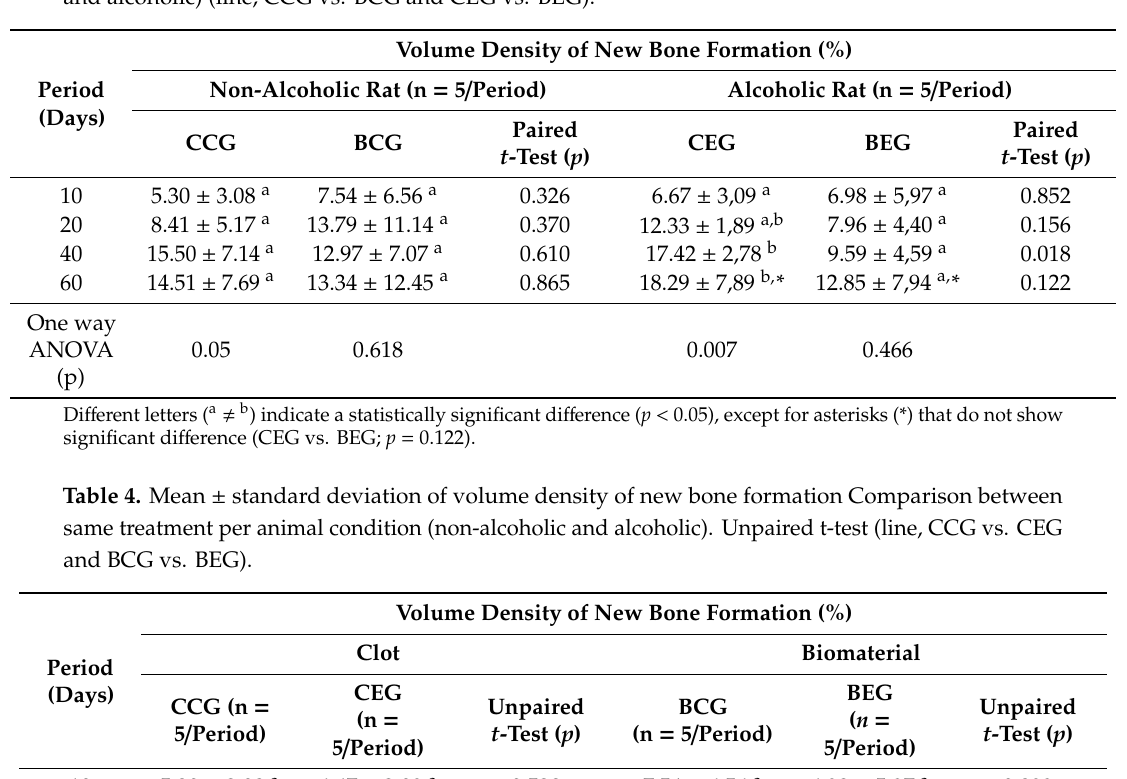
Table 3. Mean ± standard deviation of volume density of new bone formation. Comparison among periods within the same group was evaluated by one-way ANOVA (column, 10 vs. 20 vs. 40 vs. 60 days). Comparison between defects treated with biomaterial vs. clot per condition (non-alcoholic and alcoholic) (line, CCG vs. BCG and CEG vs. BEG).